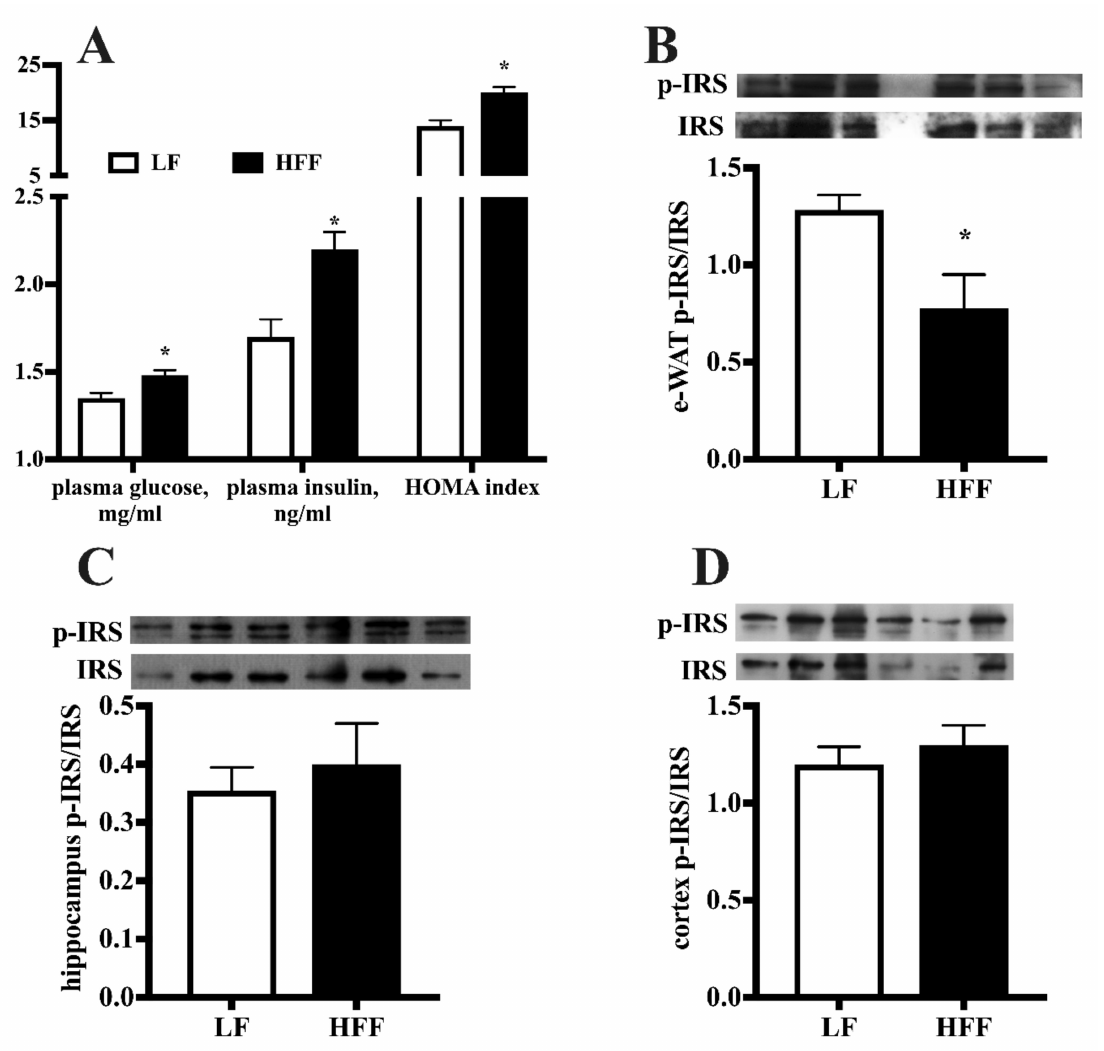
Figure 7. Plasma levels of glucose and insulin and Homeostatic model assessment (HOMA) index ( A ), protein content (with representative western blot) of phosphorylated Insulin Receptor Substrate (p-IRS) in epididymal white adipose tissue (e-WAT) ( B ), hippocampus ( C ), and frontal cortex ( D ) from middle-aged rats fed low fat (LF) or high fat-high fructose (HFF) diet for four weeks. Values are the means ± SEM of eight rats. * p < 0.05 compared to low-fat diet (two-tailed Student’s